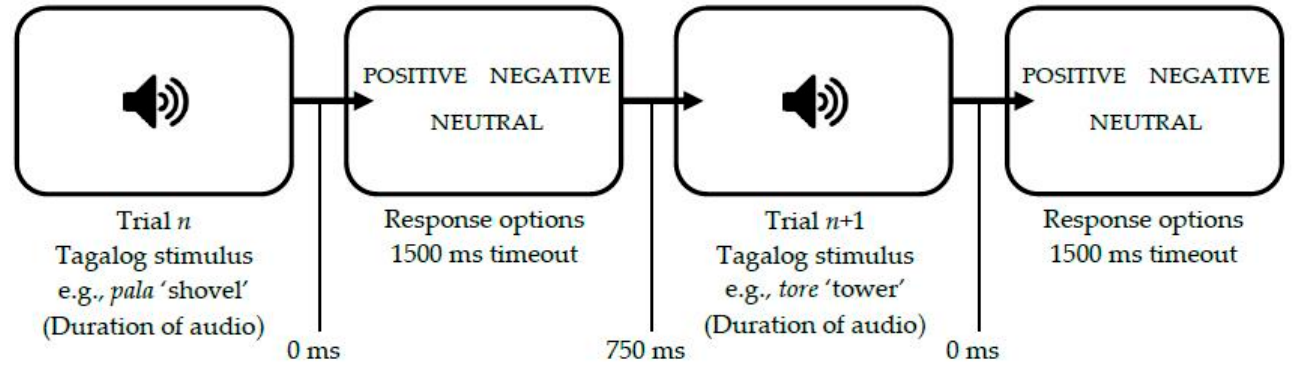
Figure 3. Trial design for condition 2 (emotion identification).